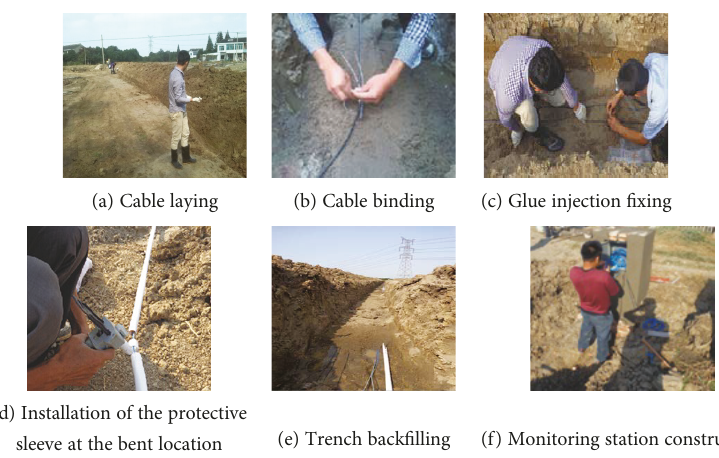
Figure 26: On-site laying of optical fi ber monitoring of the